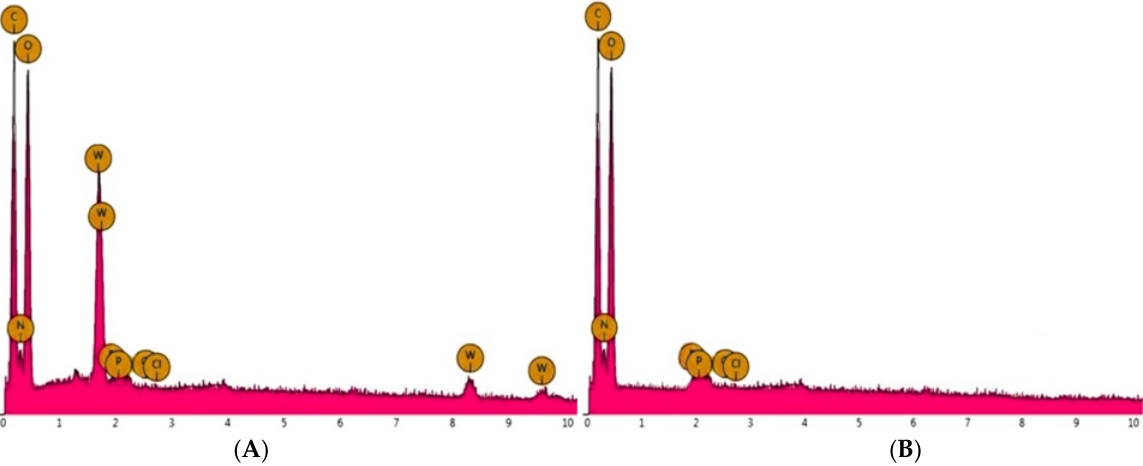
Figure 17. EDX analysis of ( A ) pregnant HNAP/QA with W(VI) and ( B ) HNAP/QA after elution.